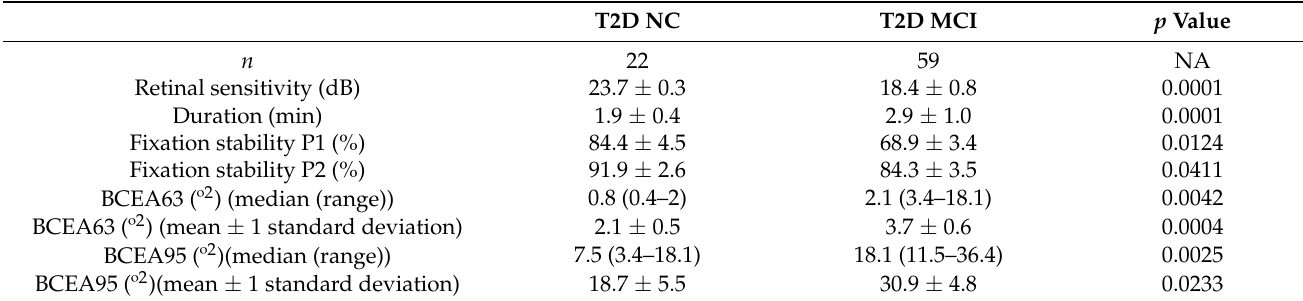
Table 3. Retinal microperimetry parameters at baseline.